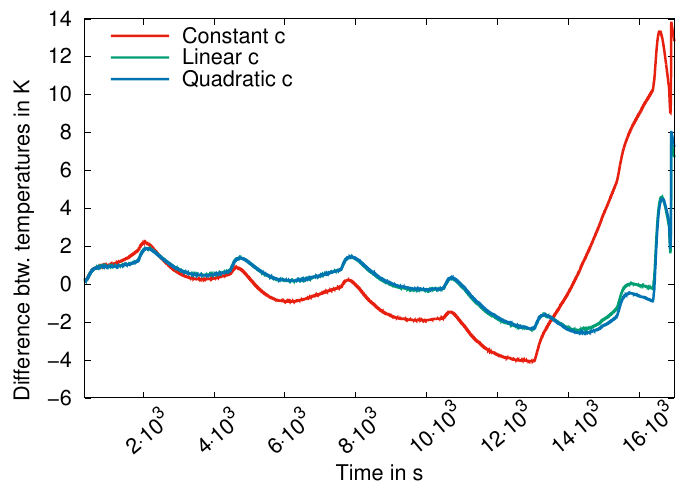
Figure 3. Differences in the quality between MPC1 (in red), MPL1 (in green), and MPQ1 (in blue) under S-MATLAB, “c” stands for heat capacities.